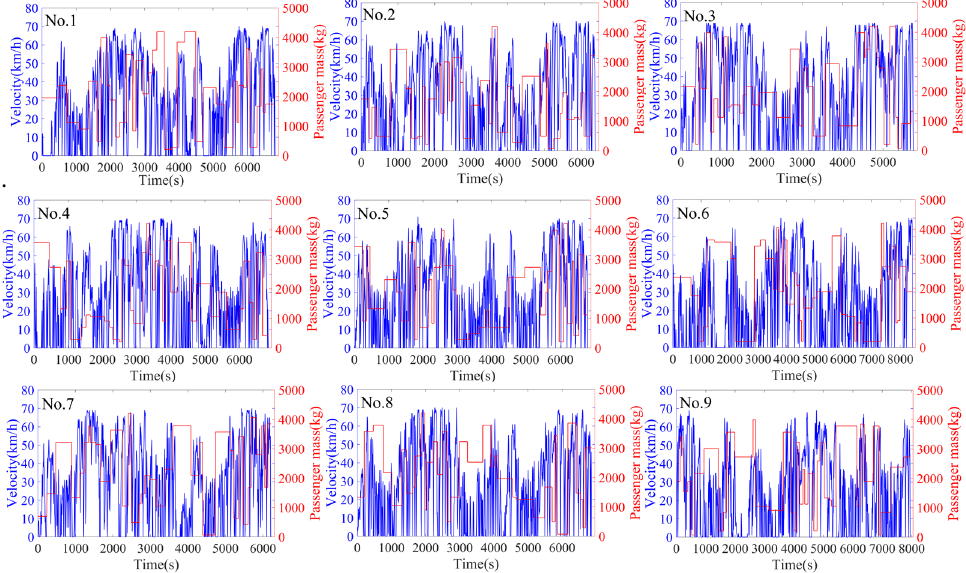
Figure 9. The combined driving cycles.